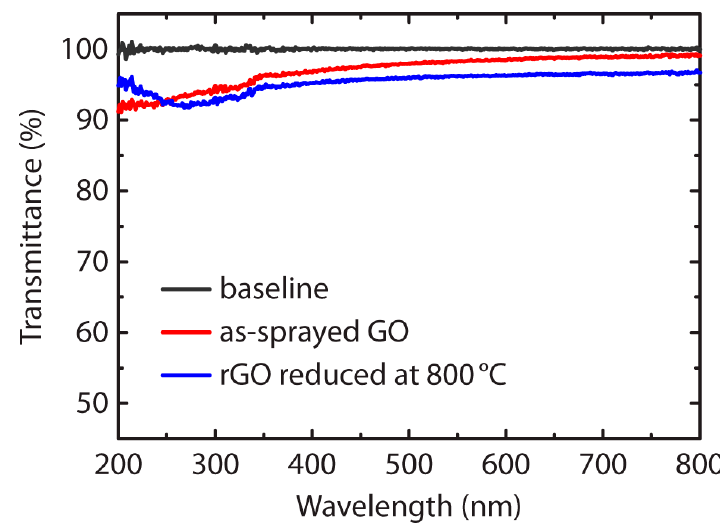
Figure 3. Transmittance spectra of the as-sprayed GO and rGO reduced at 800 °C.